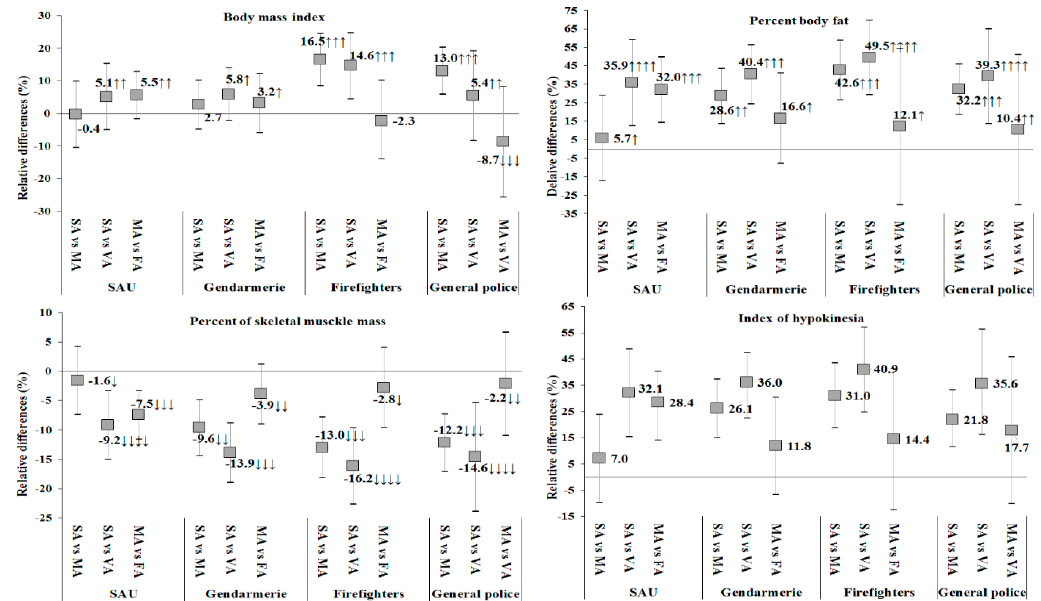
Figure 2. Relative differences (%) in body composition within each occupational group relative to V-LTPA. Small ( ↓ ), moderate ( ↓↓ ), large ( ↓↓↓ ) and very large ( ↓↓↓↓ ) negative difference. Small ( ↑ ), moderate ( ↑↑ ), large ( ↑↑↑ ), and very large ( ↑↑↑↑ ) positive difference. SA—Sedentary, MA—Moderately active, VA—Very active.